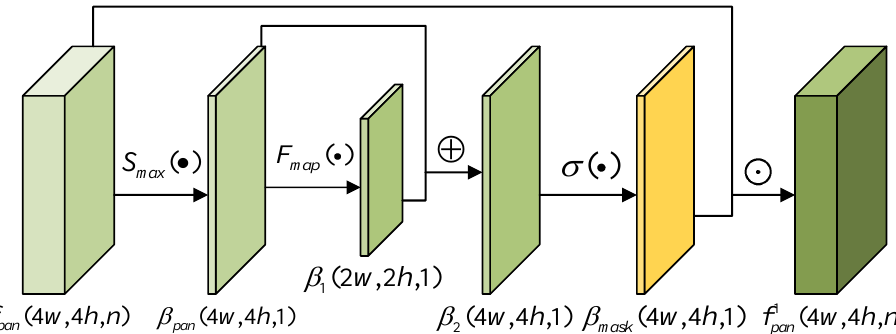
Figure 3. The proposed spatial attention module (LSA-module) for PAN